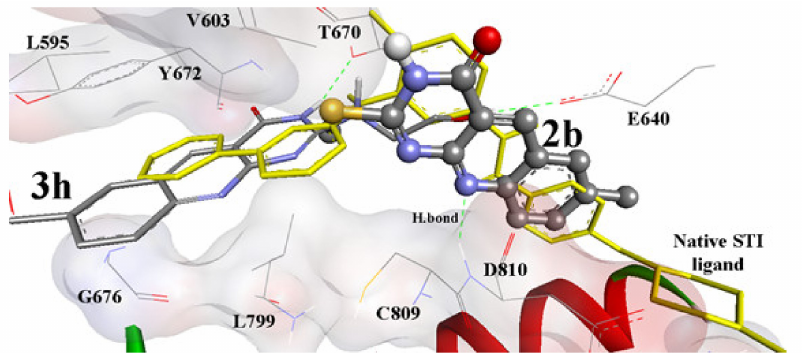
Figure 11. The comparative binding a ffi nities of compound 2b (colored by element, ball and stick) and 3h (colored by element, sticks) into the binding site of protein Tyrosine kinase (PTK) (1t46). They showed one and two hydrogen bonds with D810, E640 and T670 amino acids, respectively. The STI ligand is shown as yellow sticks. The hydrogen bonds are drawn as green dashed lines.